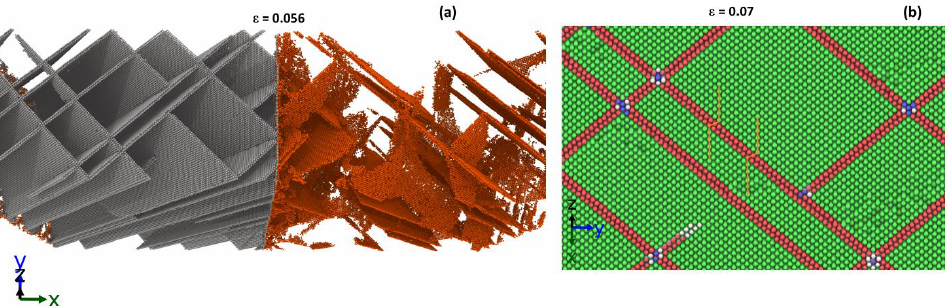
Figure 8. Development of plastic deformation in bisystem at initial pressure of 30 GPa: ( a ) formation of twin system by stacking fault planes penetrating the aluminum part of the system; dislocation processes in copper; in this panel, aluminum atoms are grey colored, copper atoms are orange colored; ( b ) aluminum twinning along the stacking fault planes; in this panel, green coloring corresponds to FCC atoms, red corresponds to HCP, violet corresponds to BCC, white corresponds to atoms with an undetectable lattice type.